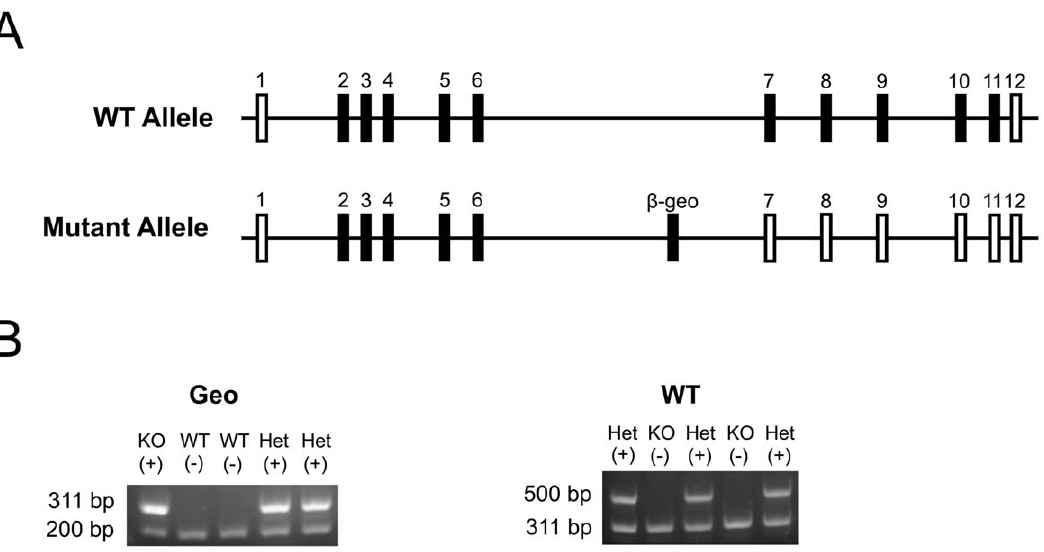
Figure 1. Generation and genotyping of Btbd9 mutant mice. ( A ) The normal wild-type (WT) allele of the Btbd9 gene contains 12 exons. A commercially available mutant allele of the Btbd9 gene has a b -geo gene trap inserted into the sixth intron. Filled vertical rectangles represent coding exons; open vertical rectangles represent non-coding exons. ( B ) To genotype the mice a two-step process was taken. First, primers were used to detect specifically the b -geo gene trap vector, which produced a fragment of approximately 311 bp in length with an internal control fragment of approximately 200 bp in length. Second, primers were used to detect specifically a WT allele, which would produce a fragment of approximately 500 bp in length and an internal control b -geo fragment of 311 bp in